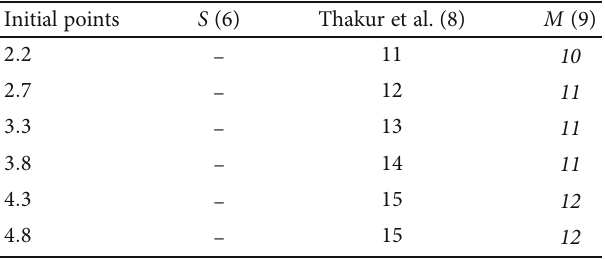
= ðð n + 3 Þ / ð 5 n + 2 ÞÞ 1/15 and β Table 4: α n Number of iterations required to obtain the fi xed point.